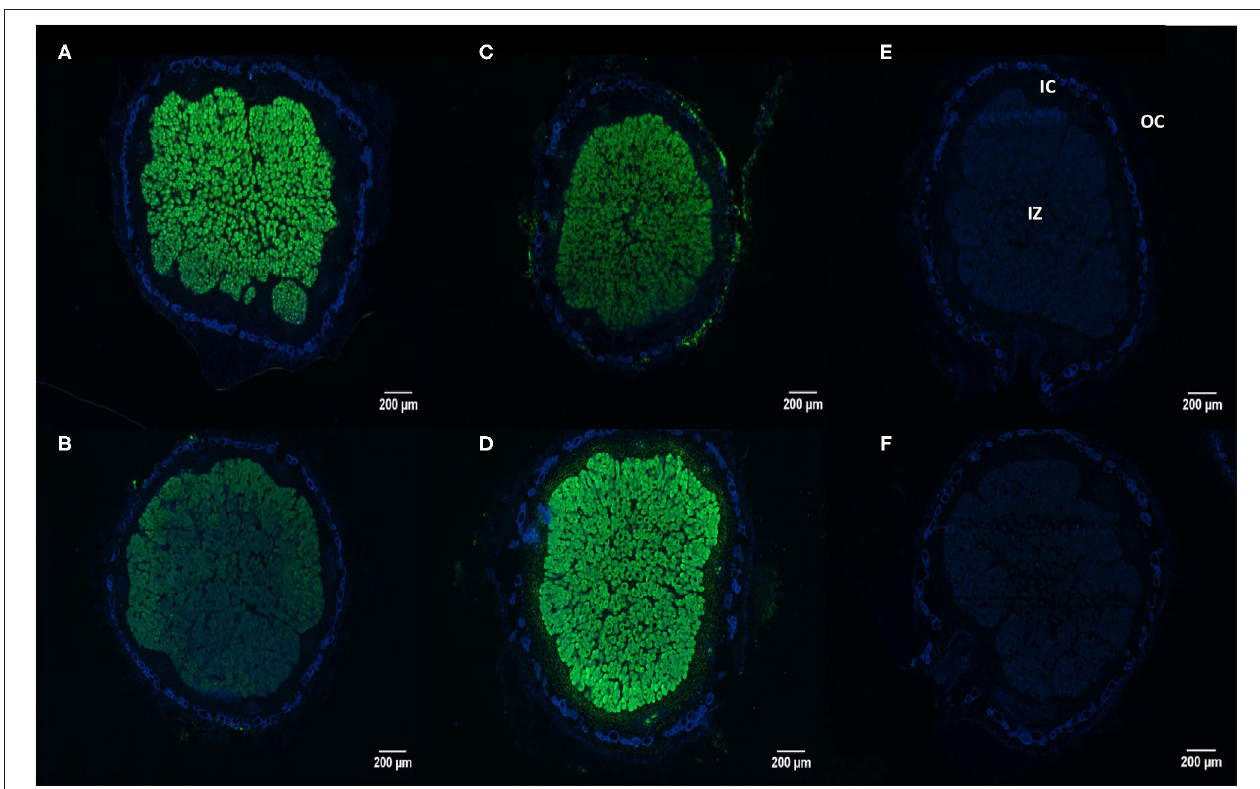
FIGURE 5 | In situ RT-PCR localization of rhizobial phytase transcripts in nodule sections of G. max - B. elkanii SEMIA 587 symbiosis, under P sufficiency (250 µ mol P plant − 1 week − 1 ), (A) cultivar N5909; (B) cultivar SR532; and under P deficiency (75 µ mol P plant − 1 week − 1 ), (C) cultivar N5909; (D) cultivar SR532. Negative controls (without reverse transcriptase) for: (E) cultivar N5909; (F) cultivar SR532. Transcripts are colored in green and nodular tissues in blue. IZ (infected zone), IC (inner cortex), OC (outer